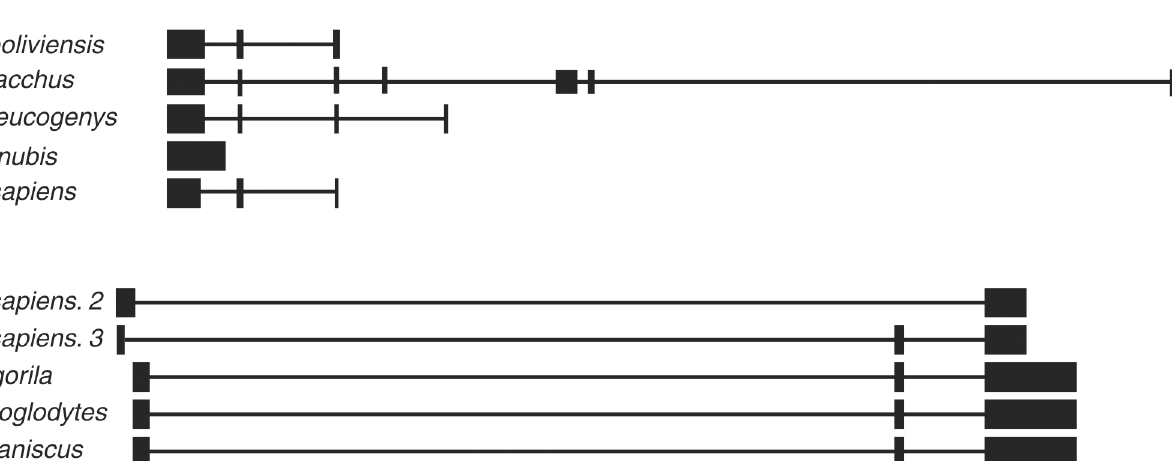
Fig 7. Evolutionary conservation of the new isoforms. A. Sequence obtained from MIR503HG2 isoform ( H . sapiens ) aligned to human genome using BLAT tool (http://genome.ucsc.edu. version : Feb . 2009 , CRCh37/hg19) with similar sequences in Saimiri boliviensis (S. boliviensis ), Callithrix jacchus ( C . jacchus ), Nomascus leucogenys ( N . leucogenys ) and Papio anubis ( P . anubis ) found in NCBI-BLAST. B. Sequences obtained from LINC0026 isoforms comprising two exons ( H . sapiens . 2) and three exons ( H . sapiens . 3) aligned to human genome using BLAT tool (http://genome.ucsc.edu. version : Feb . 2009 , CRCh37/hg19) with similar sequences in Gorilla gorilla ( G . gorilla ), Pan troglodytes ( P . troglodytes ) and Pan paniscus ( P . paniscus ) found in